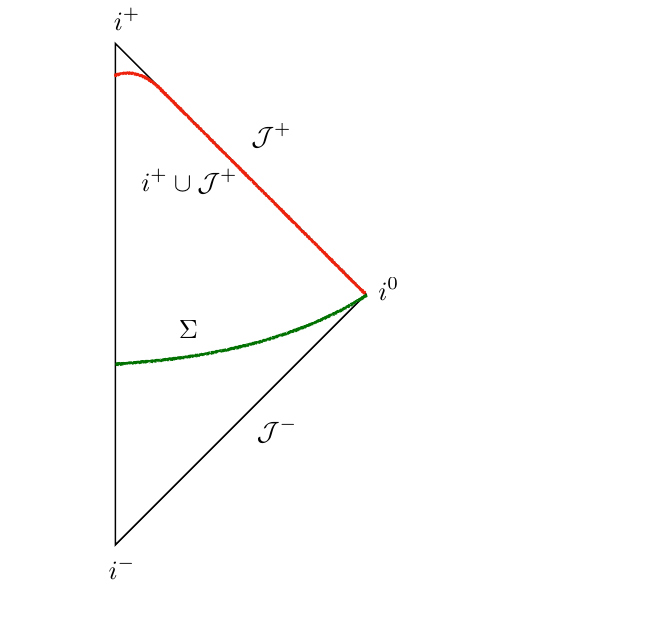
Figure 1 . Consider a spacetime with no horizons. The components of the boundary are J − , J + and the points at infinity i − , i 0 , and i + . Since the first variation of global charges is invariant under local deformations of the Cauchy surface Σ , one can deform Σ in the far future to i + ∪ J + . Then, the first variation of the Iyer-Wald global charges satisfies δQ ξ (Σ) = δQ ξ ( J + ) + δQ ξ ( i + ) . With our boundary conditions δQ ξ ( i + ) = 0